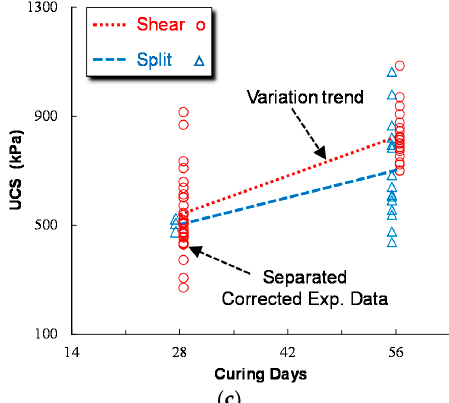
Figure 7. Variation of the UCS values obtained on cylindrical samples of cemented hydraulic backfill with a constant pulp density of 72% as a function of curing days with sand to binder ratios (S:B) of ( a ) 10:1; ( b ) 15:1; and ( c ) 20:1 (symbols for experimental data after accounting for the diagonal shear and axial split failure modes and lines for average).